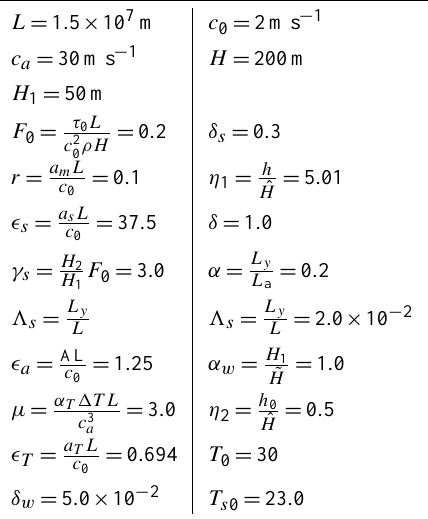
Table 1. Standard values of parameters used in the model as in (van der Vaart et al.,